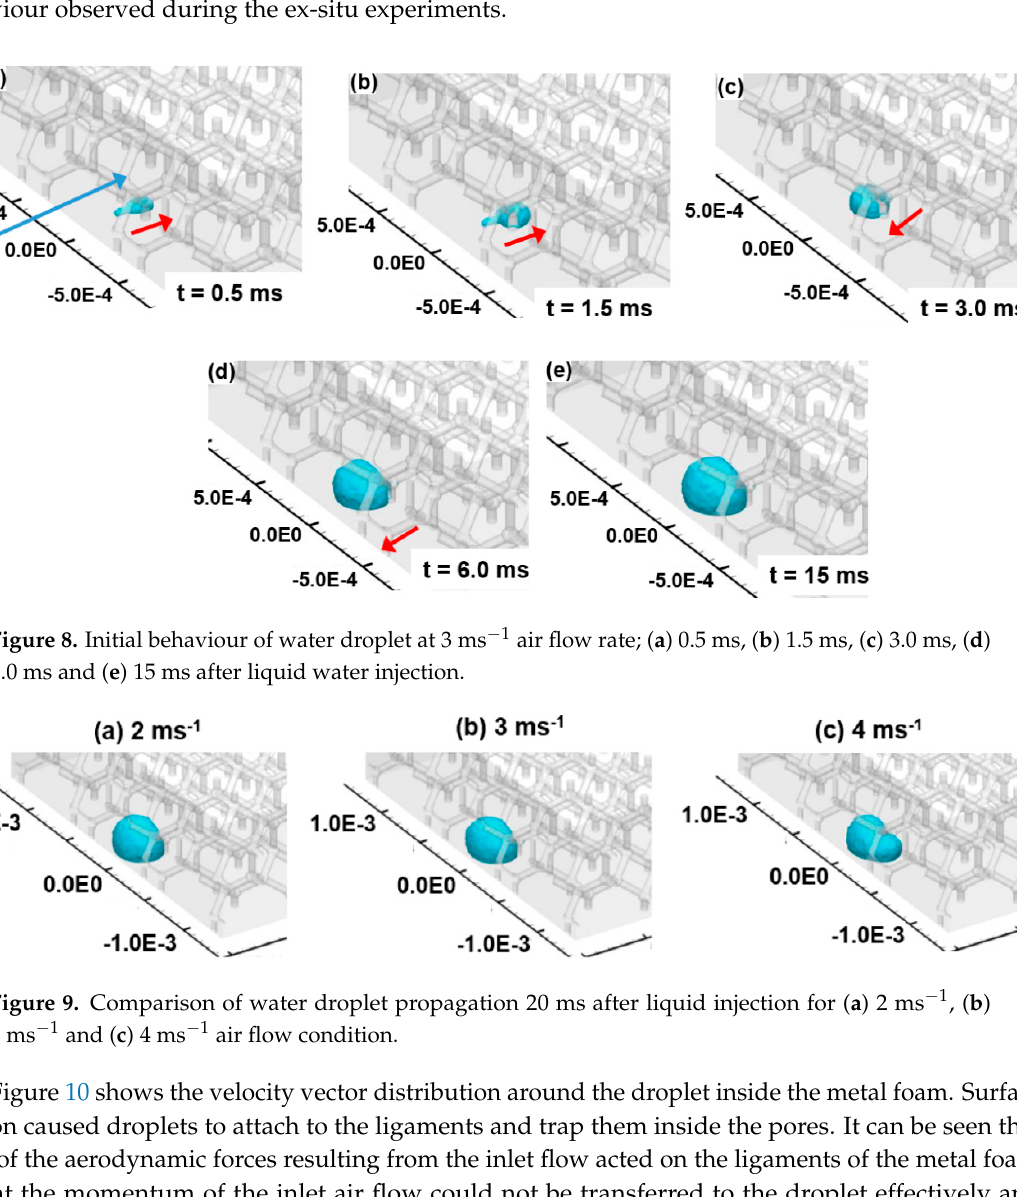
Figure 10. Distribution of velocity around the attached water droplet at t = 60 ms, air flow rate 3 ms − 1 in hydrophobic foam. The increased cross-sectional area made the aerodynamic drag acting on the droplet larger than the contact force, which led the droplet to be detached from the pore and to move in the flow direction. A new droplet was then attached to the different location of metal foam and coalesced with the second droplet that had been detached after it had grown up in the pore, forming a large droplet (Figure 11a). In a PEMFC environment this meant that once liquid water established a presence in